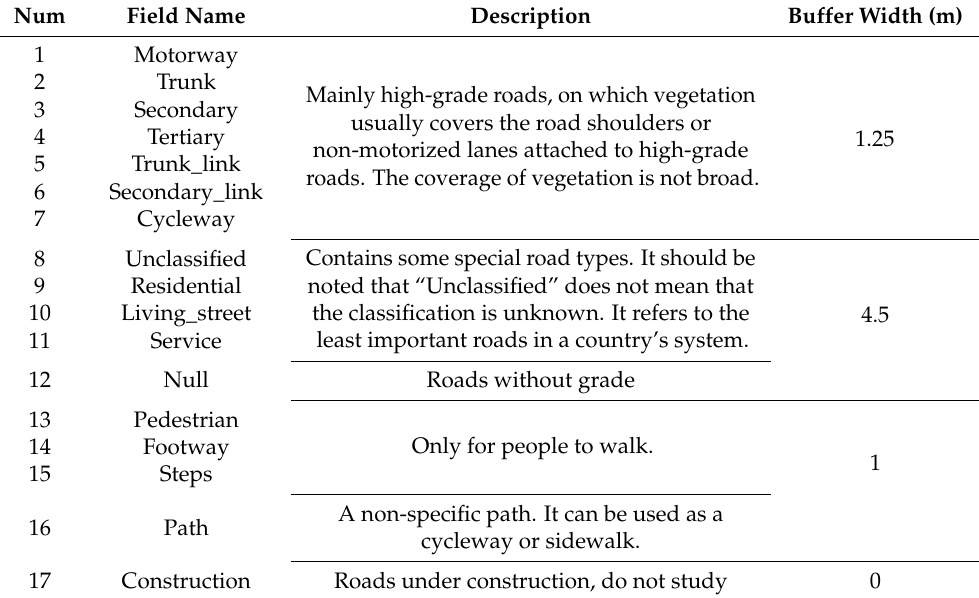
Table 2. Road grade attribute of OSM and corresponding buffer width. Figure 8. Consistency of position and direction.